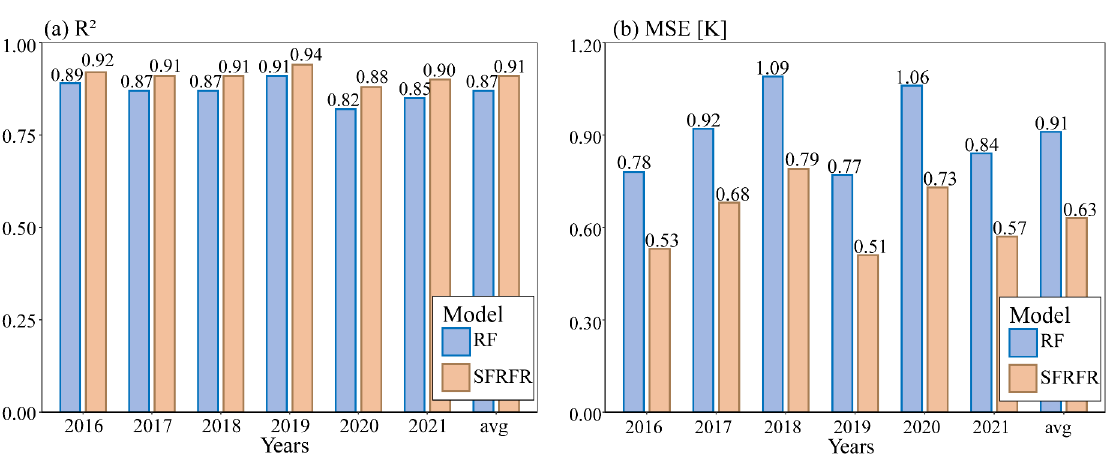
Figure 11. OOB scores of the RF regression and SFRFR models: ( a ) R 2 values of these two models and ( b ) MSE values of these two models.